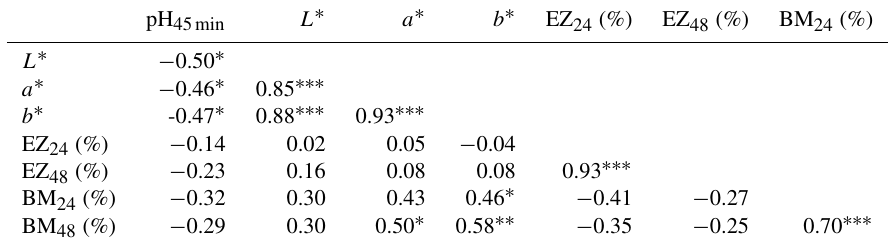
Table 2. Correlation coefficients among meat quality attributes of mutton ( n = 20) a . pH 45min L ∗ a